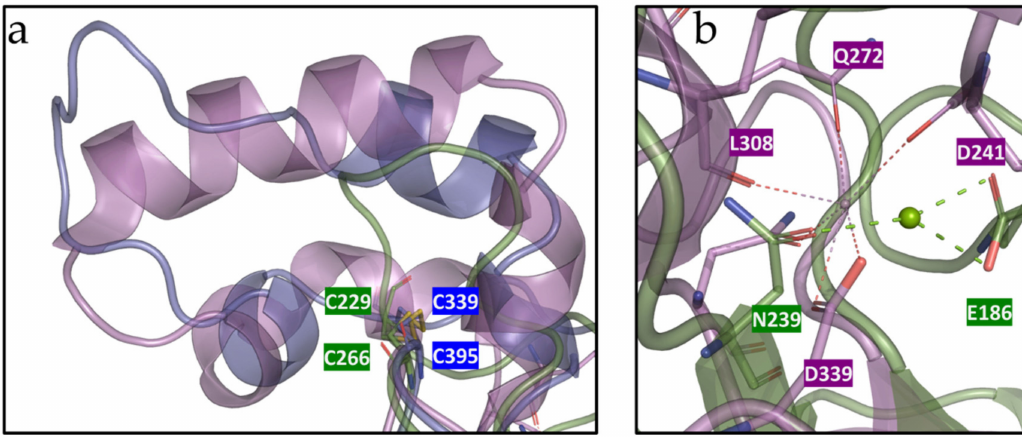
Figure 8. ( a ) Comparison of the Hmc Isc inulosucrase model (green) with B. subtilis levansucrase 1OYG (purple), and G. diazotrophicus levansucrase 1W18 (blue) and the residing cysteine bridges. ( b ) Comparison of the Ca 2+ binding site in B. subtilis levansucrase (purple) and the salt bridge in Hmc Isc